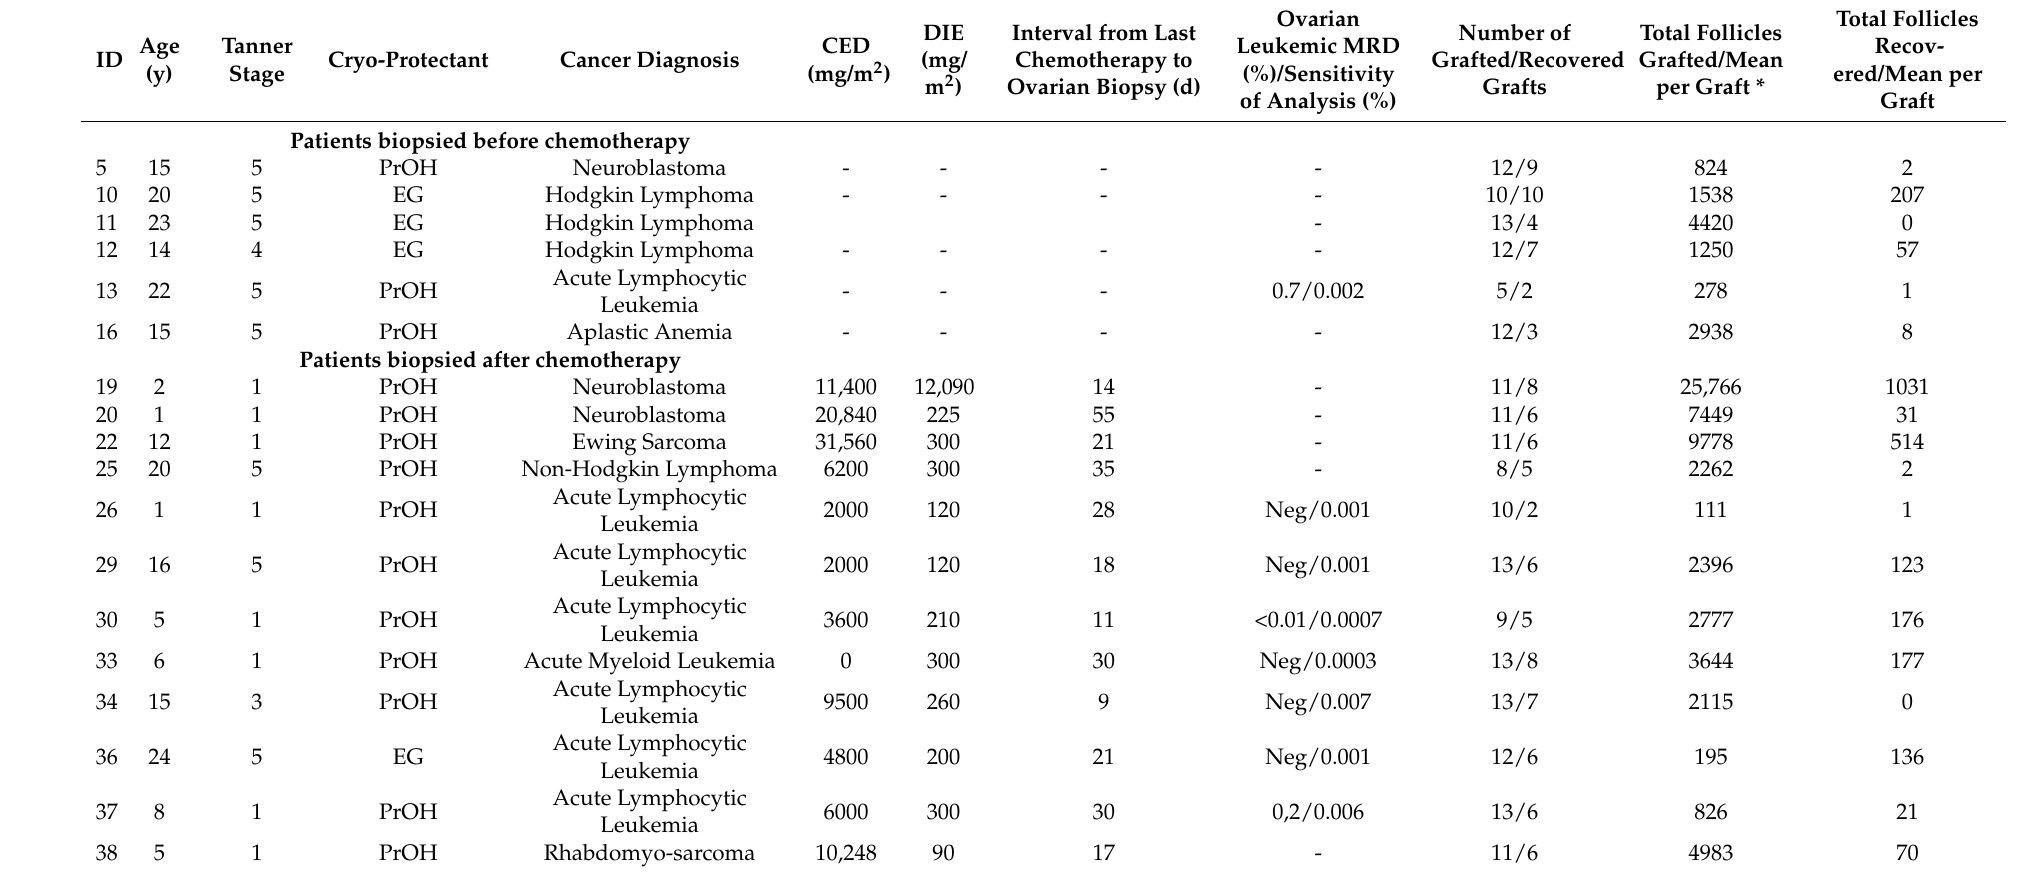
Table 1. Clinical characteristics, ovarian leukemic contamination, number of grafted and recovered grafts, and total number of follicles of each study patient. Exposure to alkylating agents is indicated by cumulative cyclophosphamide-equivalent dose (CED) and exposure to anthracyclines by doxorubicin